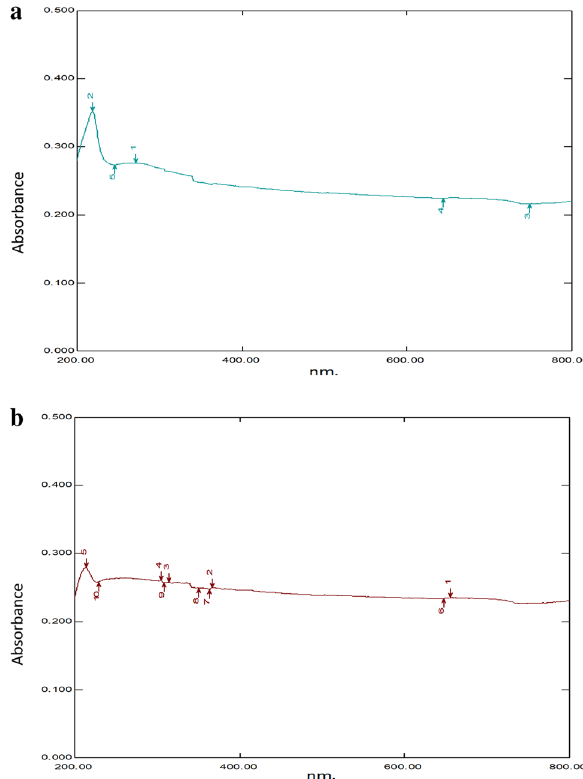
Fig. 1 UV–Vis analysis of a SPIONs, b chitosan-coated SPIONs